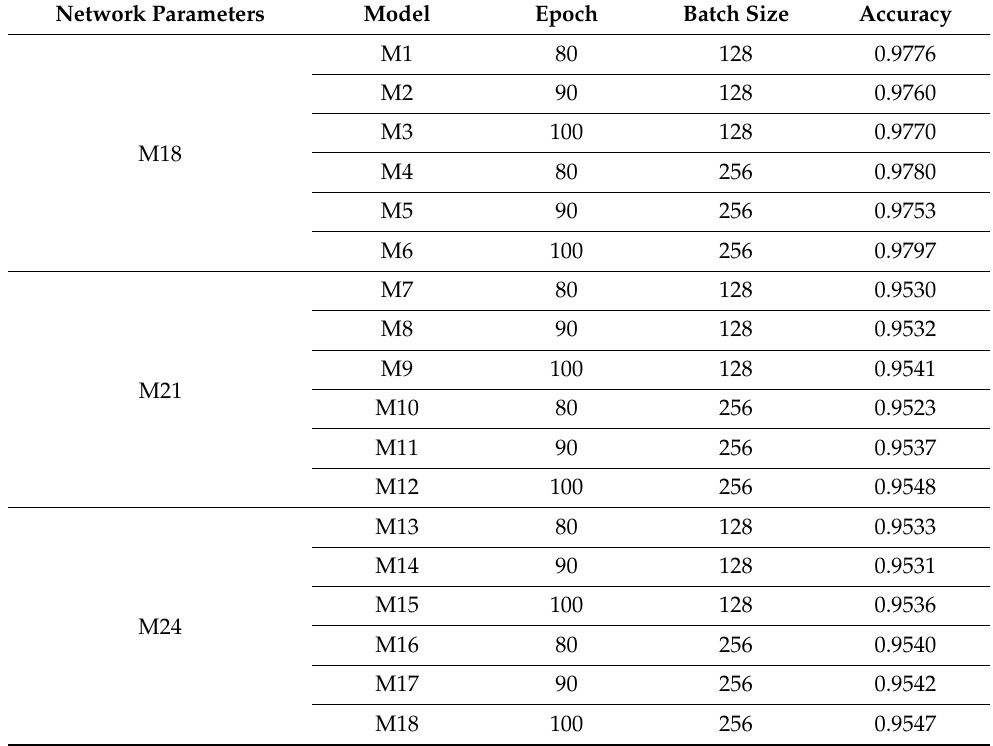
Table 3. Tuning of